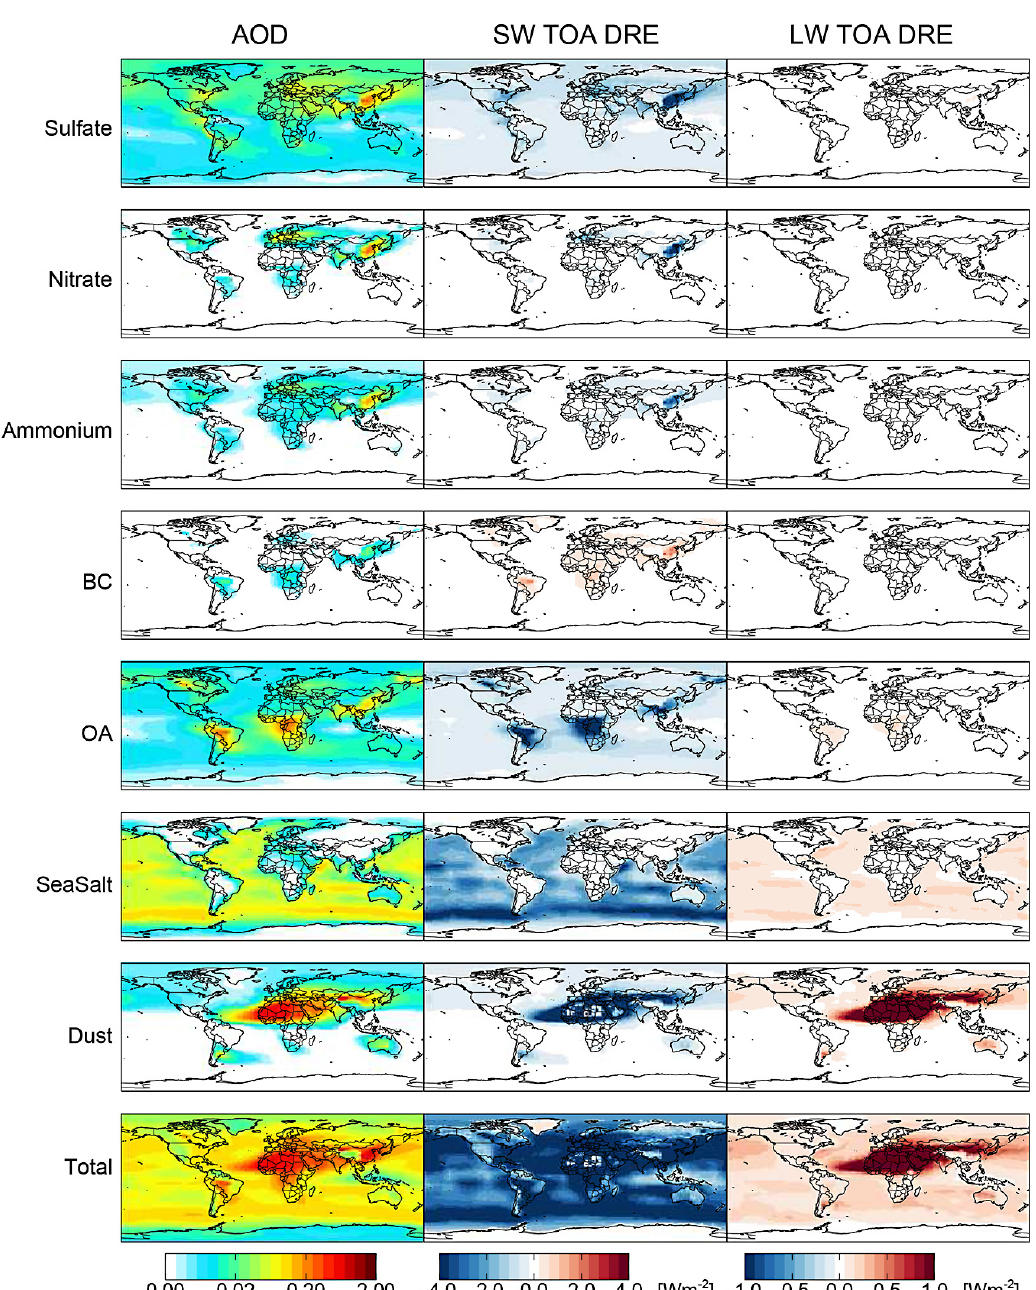
Figure 2. Annual mean AOD (left), shortwave TOA clear-sky direct radiative effect (center) and long-wave TOA clear-sky direct radiative effect (right) simulated by GC–RT for 2010. Color bars are saturated at respective